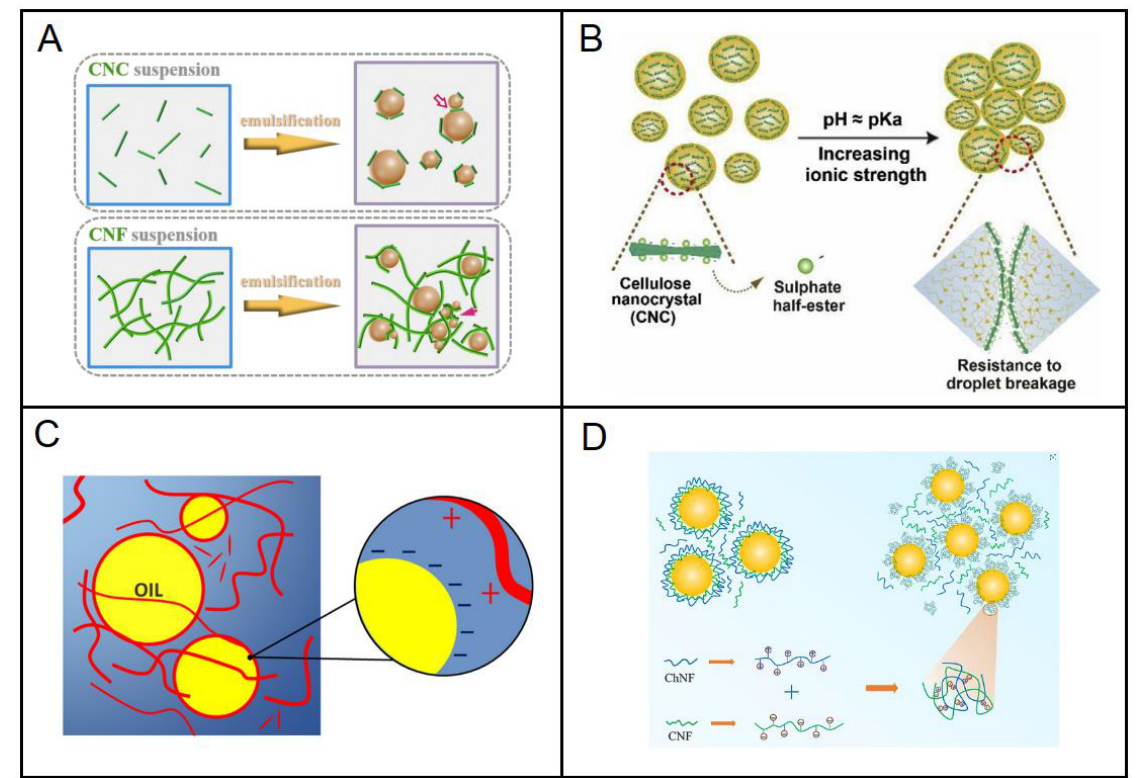
Figure 8. ( A ) Schematic representation of CNC and CNF suspension along with the olive-oil-in- water emulsion stabilized by CNC and CNF. Reproduced with permission from [52], [Carbohydrate Polymers]; published by [Elsevier, 2021]. ( B ) Schematic illustration of CNC-stabilized corn-oil- in-water emulsion under different pH environments. Reproduced with permission from [118], [Food Hydrocolloids]; published by [Elsevier, 2019]. ( C ) Schematic diagram of the proposed dual stabilization mechanism of cationic CNF-stabilizing almond-oil-in-water emulsion. Reproduced with permission from [121], [Journal of Colloid and Interface Science]; published by [Elsevier, 2020]. ( D ) Schematic representation of 2 possible stabilization mechanisms of CNF and chitin nanofibrils mixture stabilizing corn-oil-in-water emulsion. Reproduced with permission from [122], [Food Hydrocolloids]; published by [Elsevier,